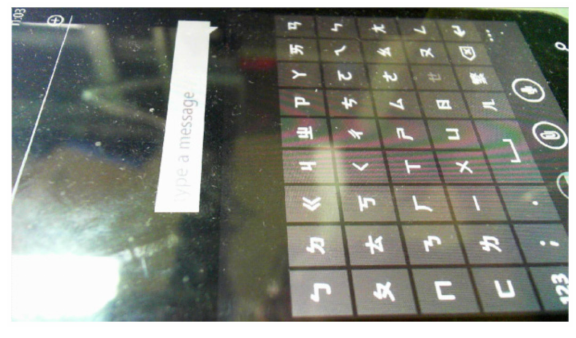
Figure 17. RGB image.